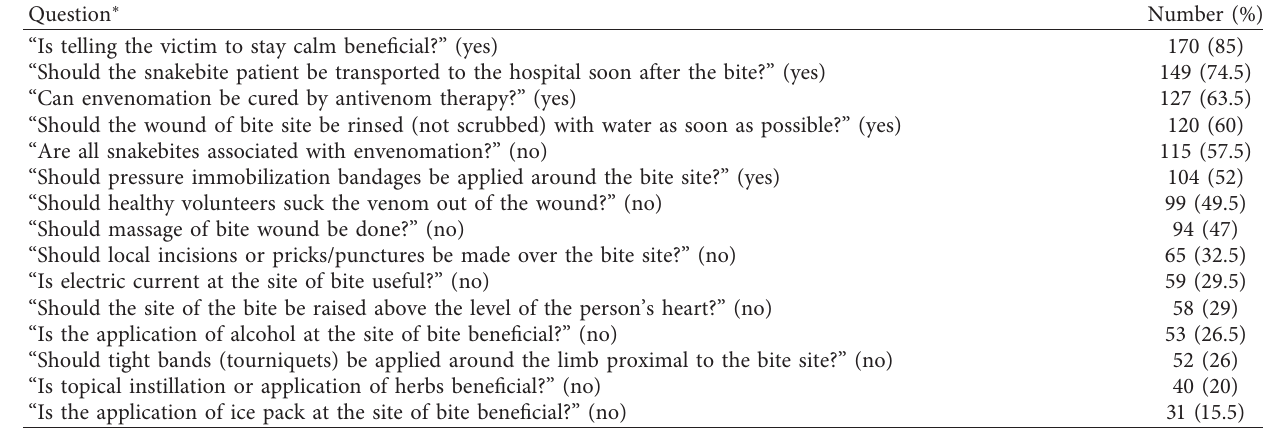
Table 7: Percentages of correct responses of nursing students to questions on knowledge regarding first aid in case of snakebites. Question ∗